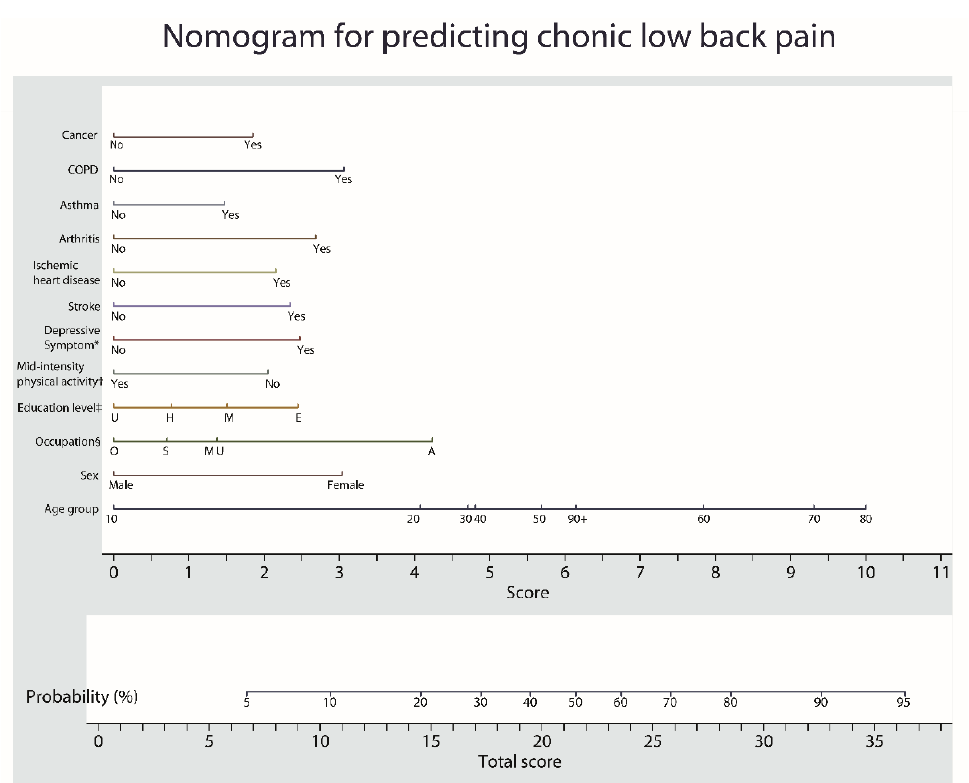
Figure 4. Nomogram for predicting chronic low back pain based on the risk factors. The value of each risk factor is respectively loaded on each variable axis (the 1st–12th lines), and a line is drawn downwards to determine the number of points received for each variable (the 13th line). Then, the sum of these numbers is located on the total points axis (the last line), and a line is drawn upwards to the risk probability axis to determine the likelihood of chronic low back pain. COPD, chronic obstructive pulmonary disease. * Depressive symptom was defined as individuals in this survey who felt sad or had a depressive symptom for two consecutive weeks during the past year. † Mid-intensity physical activity was defined as mid-intensity physical activity for 5 or more days per week for